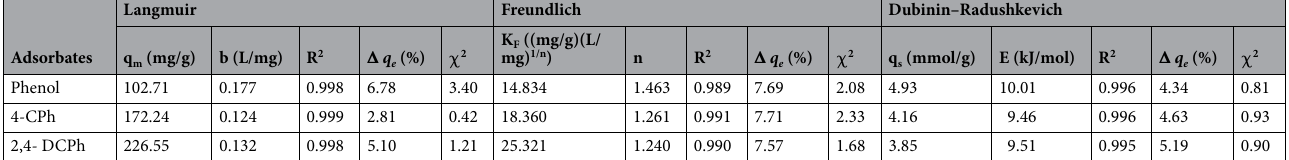
Table 4. Isotherm Parameters of 4-CPh and 2,4-DCPh on